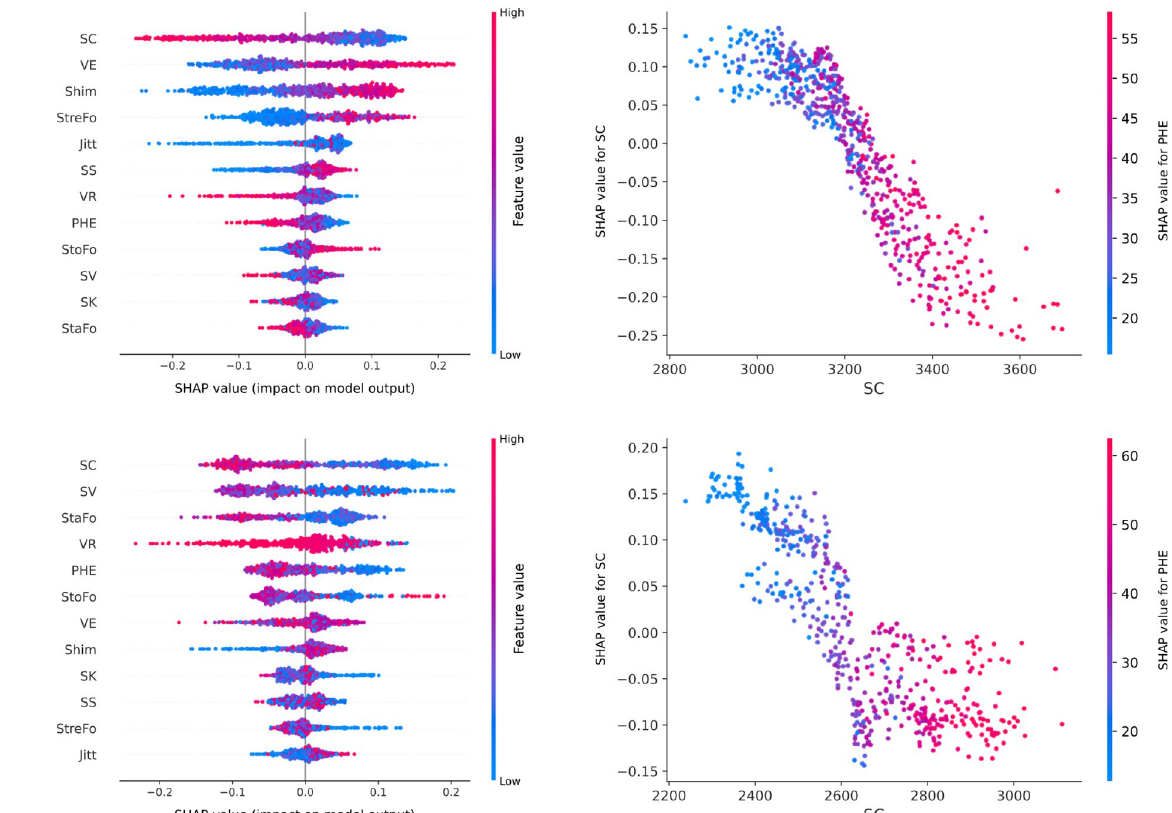
Figure 4. Left side: SHAP summary plots of input features for sopranos (upper row), as well as tenors and baritones (lower row). Features are sorted in descending order of the impact on the model output. Right side: SHAP dependence plots showing the impact of the interaction between SC and PHE. In all plots, only the results for the dramatic voice structure are